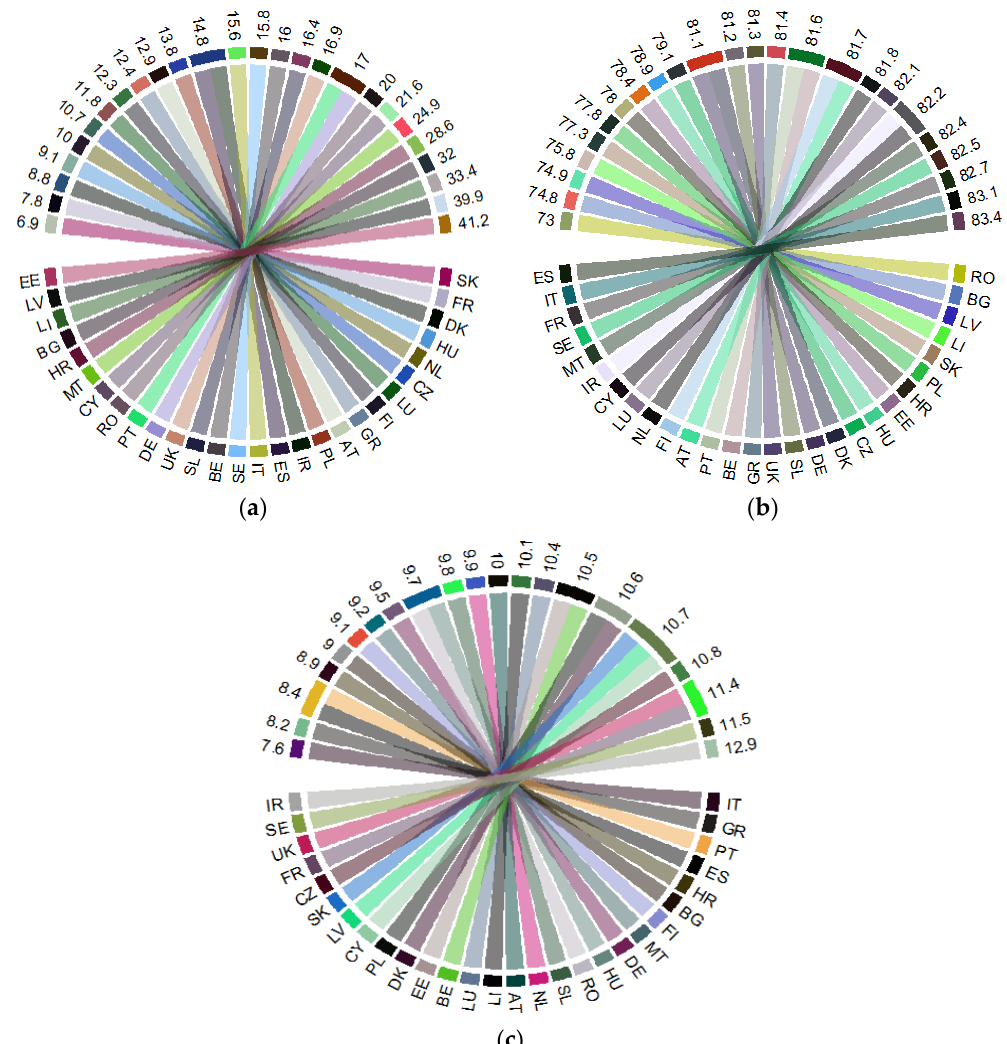
Figure 3. Poverty 65+ and the aging dimensions within the EU, in 2017: ( a ) “At-risk-of-poverty-rate of older people, 65+ (%)” (POV_65); ( b ) “Life expectancy at birth, total population (years)” ( LE ); ( c ) “Crude birth rate (number of live births per 1000 people)” (BR). Source: own process in R version 3.6.3. (R Foundation, Free Software Foundation’s GNU General Public License, Boston, USA), based on Eurostat data [18]. Legend: AT—Austria; BE—Belgium; BG—Bulgaria; HR—Croatia;